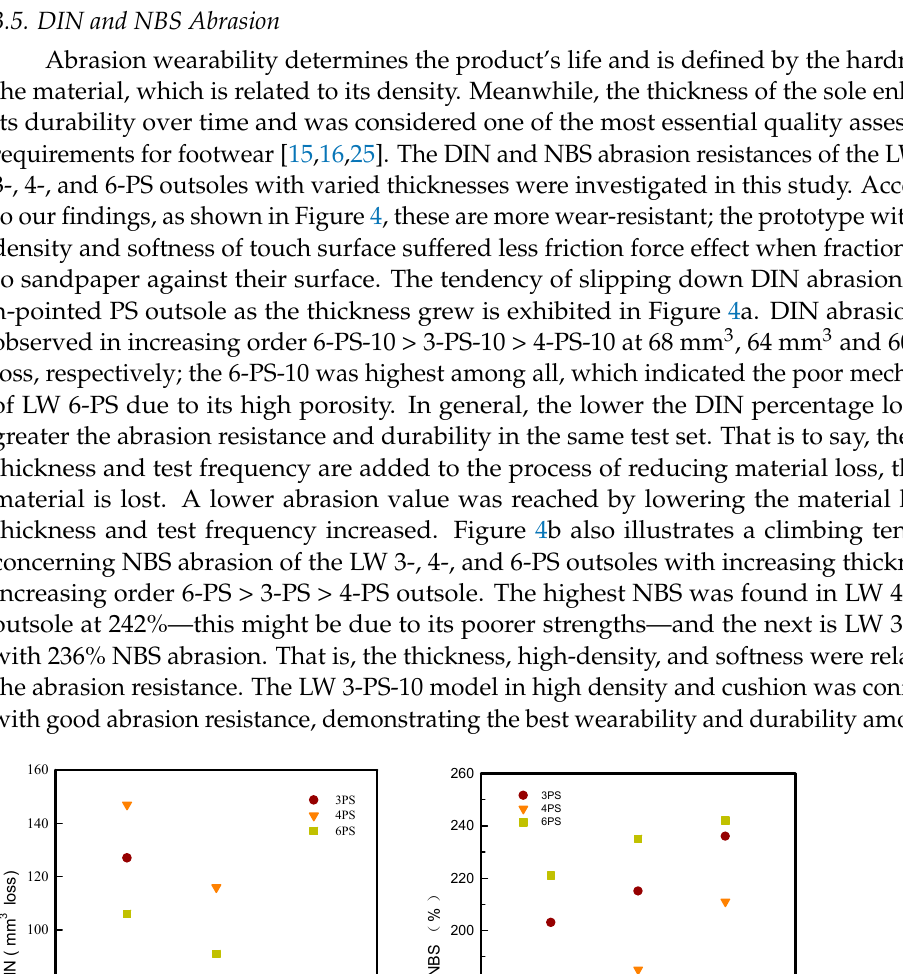
Figure 3. Static ( a ) and dynamic ( b ) coefficient of friction of the LW 3DP 3-, 4-, and 6-SP outsole with various thicknesses.